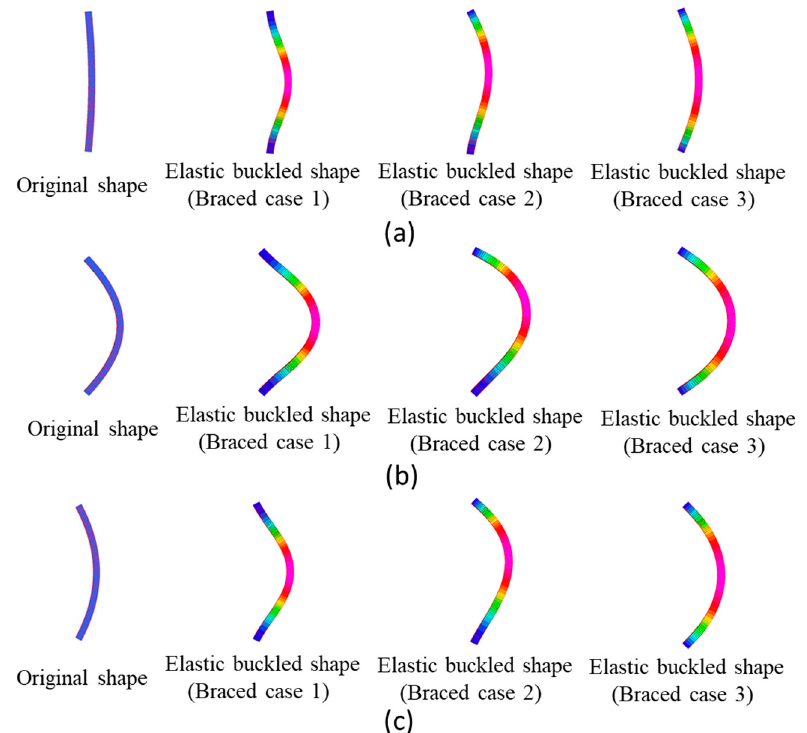
Figure 18. The effective length factor ( 𝑘 (cid:3032) ) of curved columns under different L/R ratios: ( a ) braced member case 1; ( b ) braced member case 2; ( c ) braced member case 3.